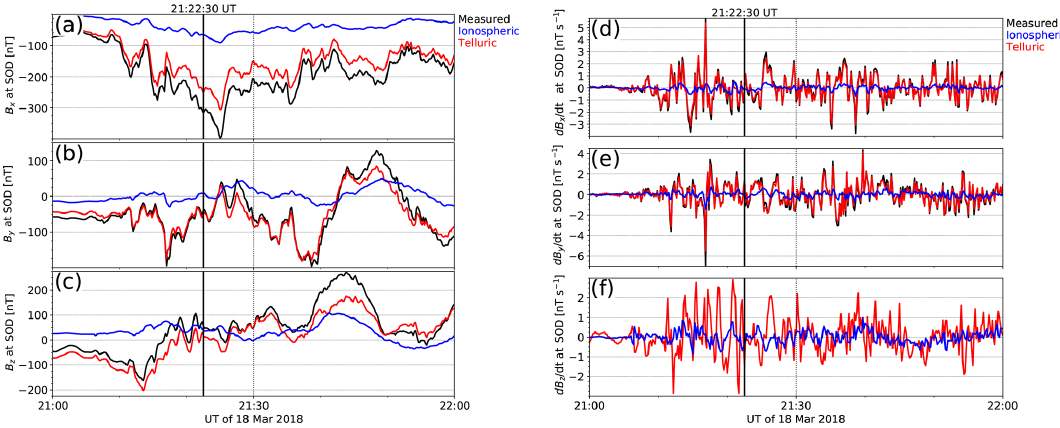
Figure 10. Magnetic field at SOD in the same format as Fig. 4, except that the internal, instead of the real, measured ground magnetic field has been given as input to the SECS field separation. “Measured” refers to the internal magnetic field from the original analysis, “Ionospheric” to the external magnetic field from the reanalysis, and “Telluric” to the internal magnetic field from the